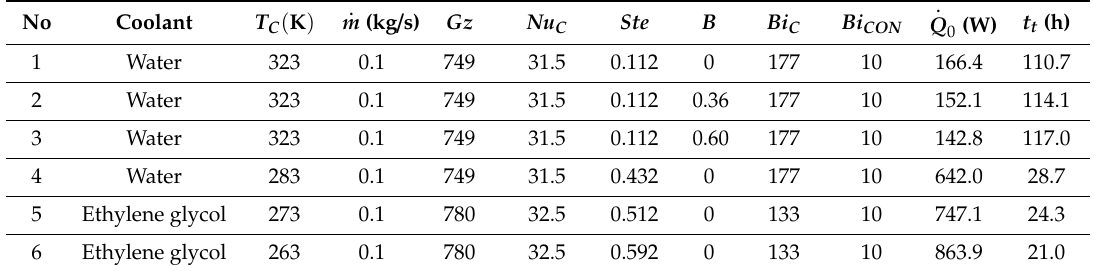
Table 1. The values of the main parameters for RT64HC.